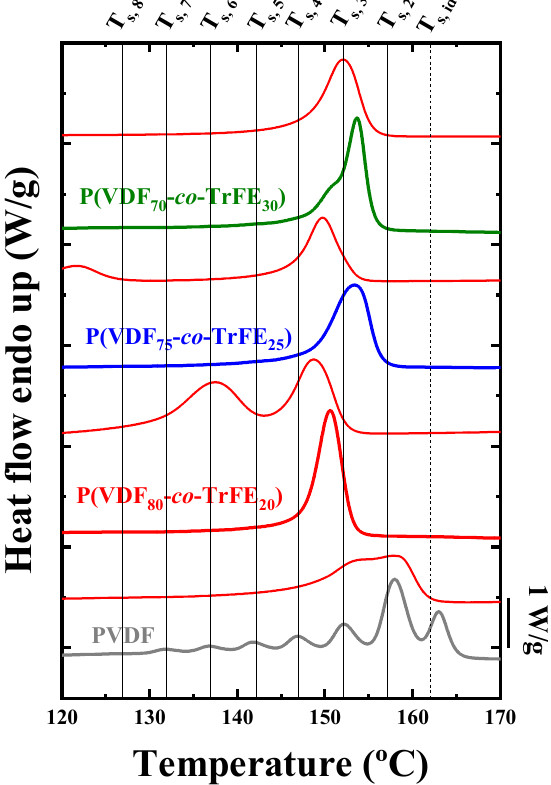
Figure 11. Final DSC heating scans after the SSA protocol for neat PVDF and the indicated copolymers. The name of each sample is written on top of each final SSA DSC scan. For comparison purposes, the DSC scans drawn with thin red lines (above each DSC scan after SSA) correspond to the standard DSC heating scans of the corresponding samples.